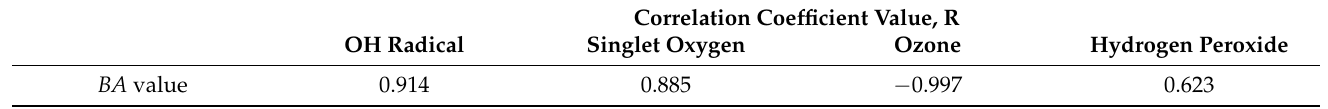
Table 2. Correlation coefficient value (R) of BA values and reactive